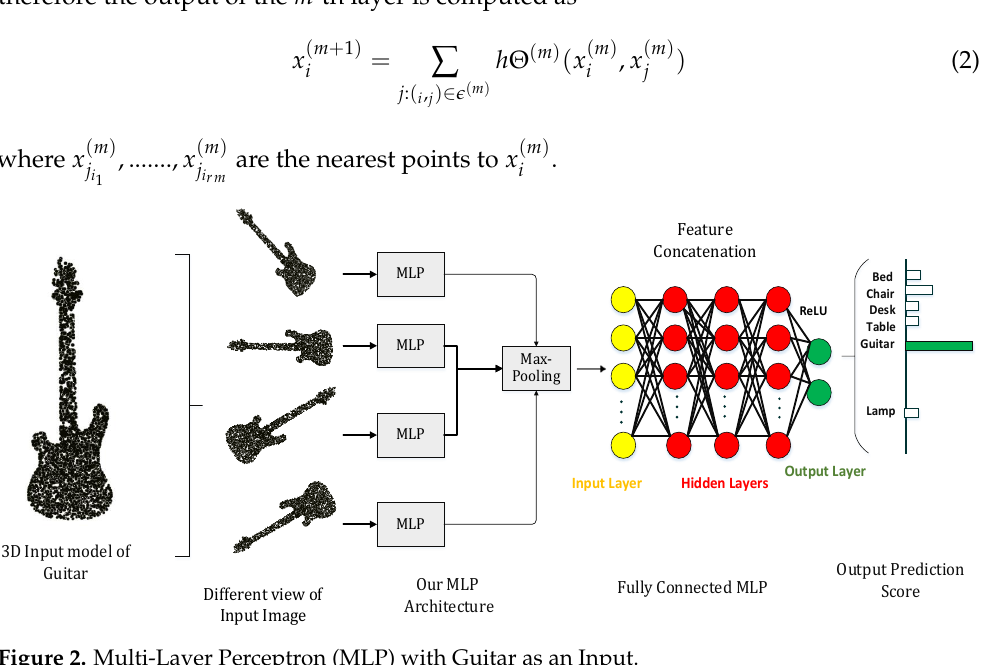
Figure 2. Multi-Layer Perceptron (MLP) with Guitar as an Input.